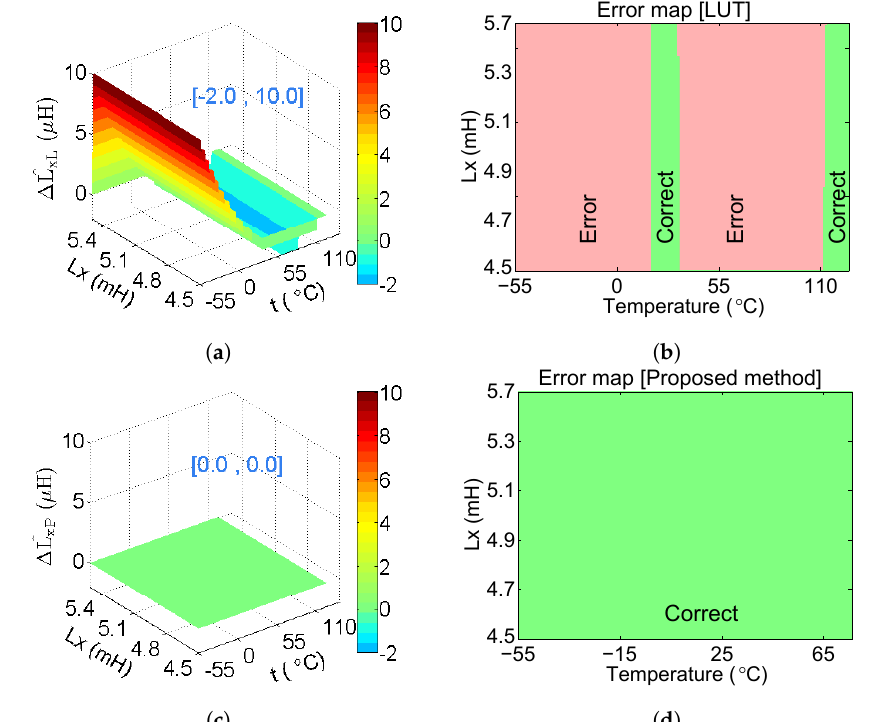
Figure 11. ( a ) ˆL x with different { L x ,t } (ˆL x exhibits a large deviation under the low temperature L L = L x , and the range); ( b ) error map of ˆL x (the green areas indicate the correct computation that ˆL x L L (cid:54) = L x ); ( c ) ˆL x = 0 red areas indicate the incorrect computation that ˆL x with different { L x ,t } (ˆL x L P P demonstrates that the deviation is reduced obviously); ( d ) error map of ˆL x (all the areas are green, P indicating that the proposed method can obtain correct results for all the